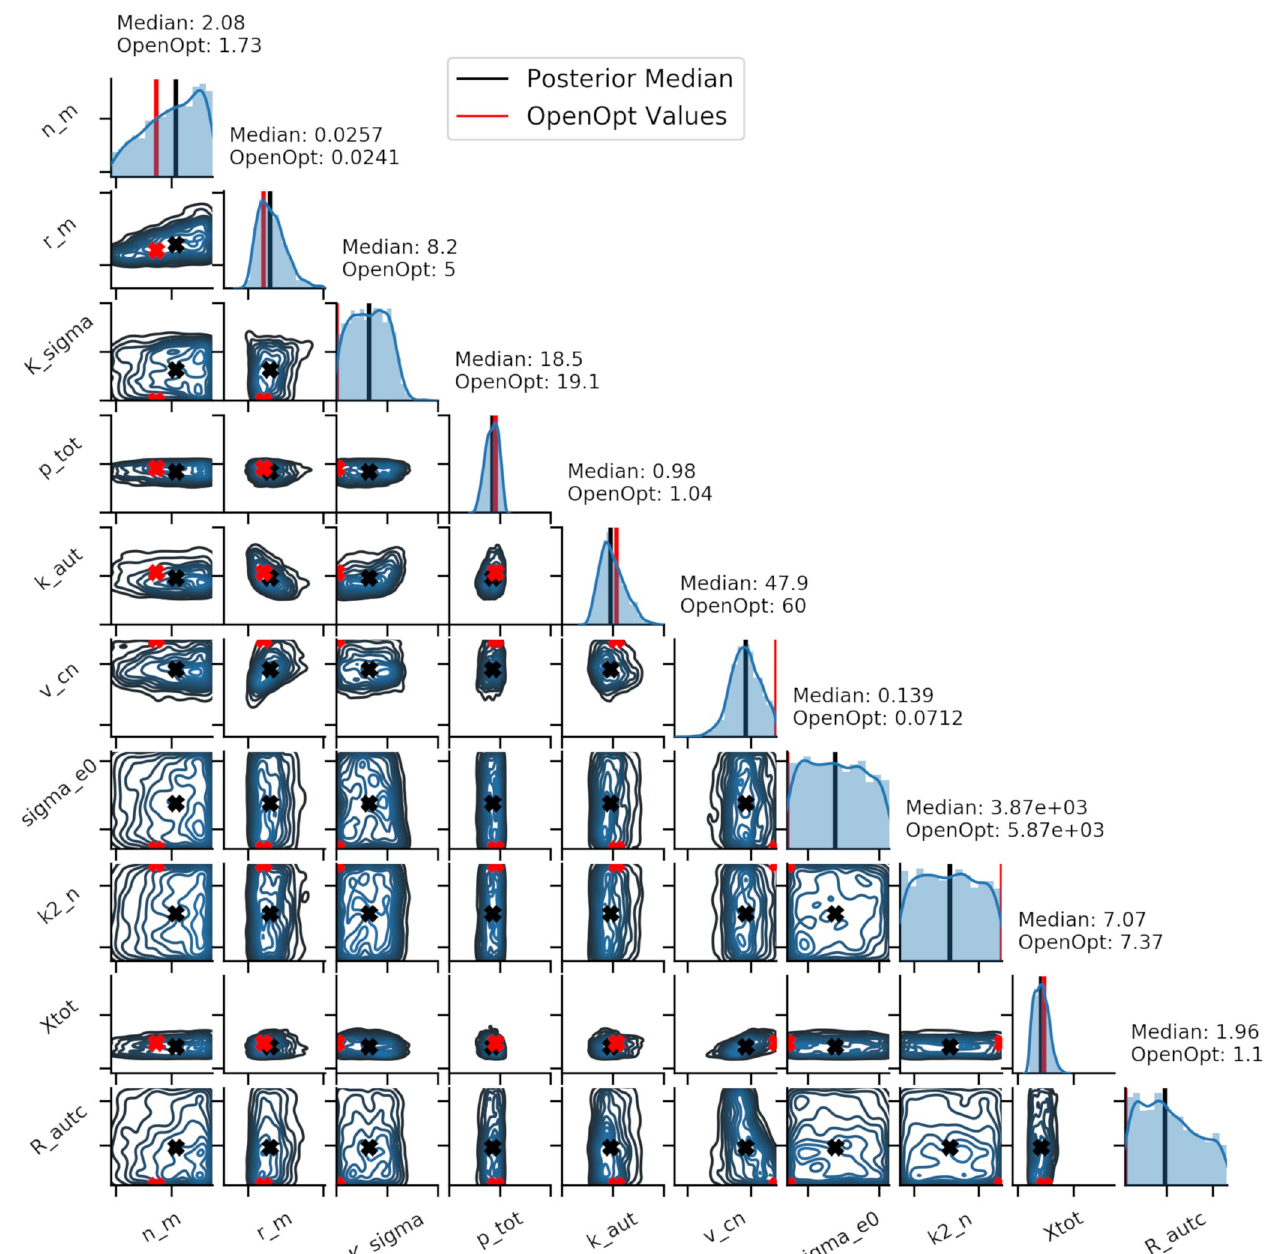
Fig 11. Posterior distributions for the experimental data set. Fig 11 shows the posterior distribution for the experimental data set, based on an acceptance rate of 0.01%. The posterior median is shown in black and the OpenOpt predicted value is shown in red. Posterior are shown over the full prior range as defined in S3